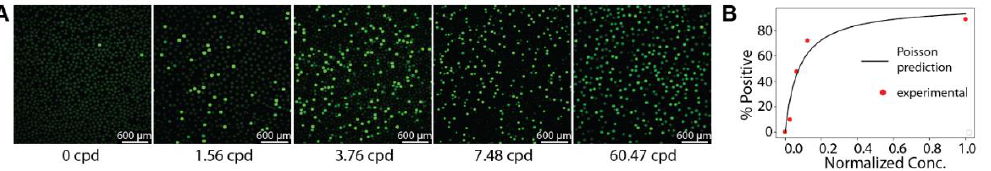
Figure 3. Droplet digital LAMP. ( A ) Post-amplification micrographs of droplets. ( B ) Agreement between Poisson predicted positive droplet percentage and experimental data.